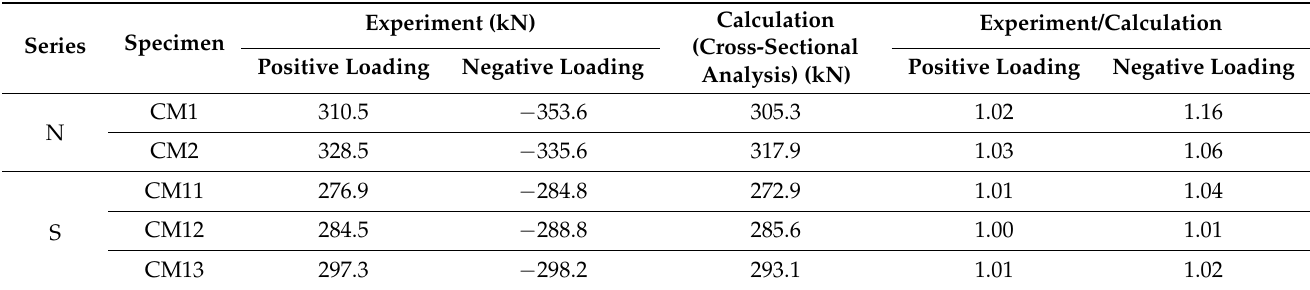
Table 6. Maximum strength by experiment and calculation (cross-sectional